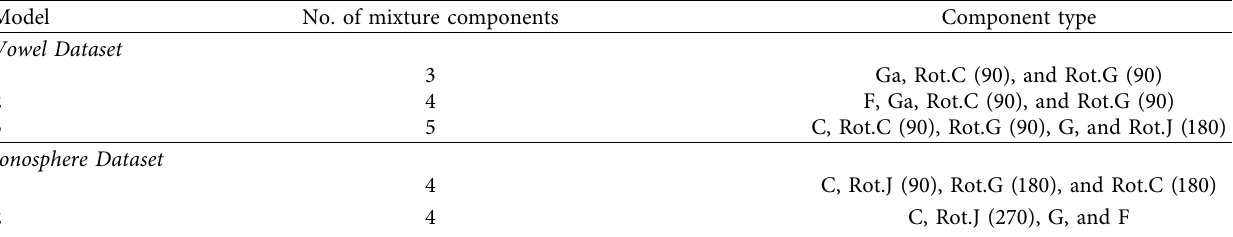
Table 8: Selection criteria values of the second scenario of the simulation study.